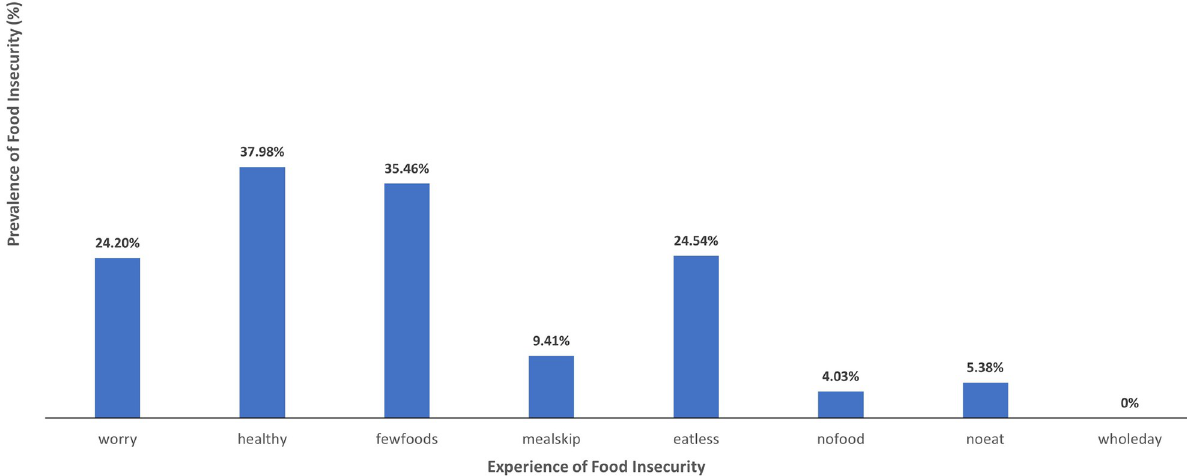
Fig 3. Self-reported experiences along the food insecurity experience (FIES)